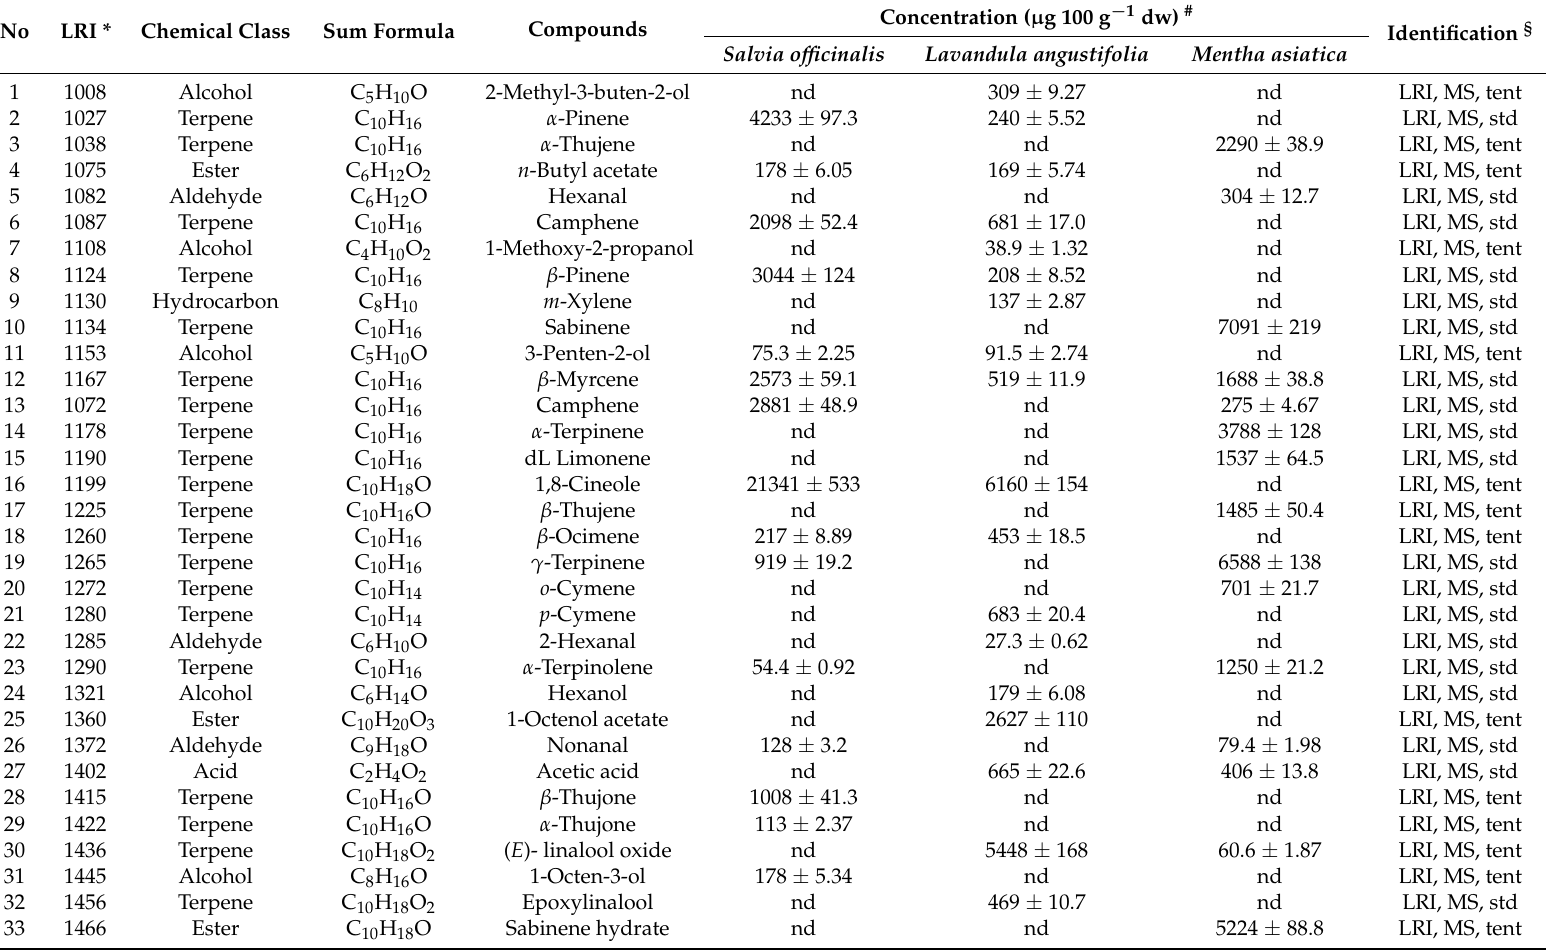
Table 1. Aroma compounds of Salvia officinalis Lavandula angustifolia and Mentha asiatica